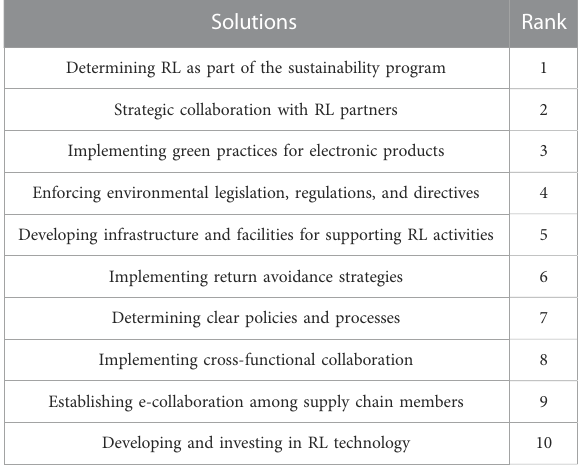
TABLE 8 Final rank of solutions (Source: Author).